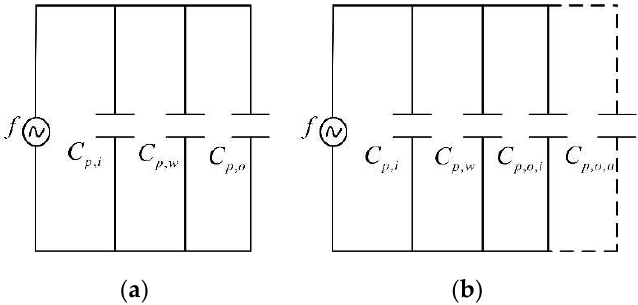
Figure 4. The measurement of the dielectric constant of an icing sample.